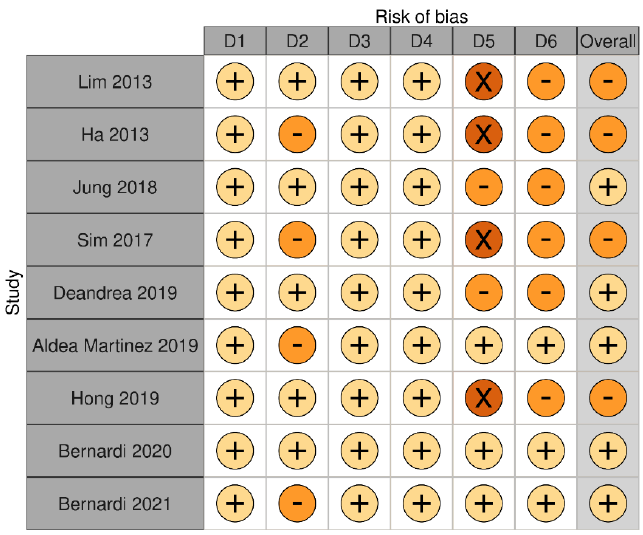
Figure 2. Bias assessment of studies on RFA long-term outcomes in patients with benign thyroid nodules. Risk of bias was classified as low (+) (pale yellow), unclear (-) (orange) or high (x) (brown). Risk of bias was based on the judgement of domains D1–D6. D1 is for selection of participants; D2 is for confounding variables; D3 is for measurement of intervention (VRR); D4 is for blinding of outcome assessment; D5 is for incomplete outcome data during follow-up; D6 is for selective outcome reporting. Risk of bias was judged unclear in D2 when number of RFA sessions or energy delivered were not specified. Risk of bias was judged high in D5 when the number of patients seen at specific follow-up time points was not specified. Risk of bias was judged unclear in D5 when the number of patients was lower than 80% of patients enrolled. Risk of bias in D6 was based on D5. Table 1. Main findings of studies on RFA long-term outcomes in patients with benign thyroid nodules. Study Main